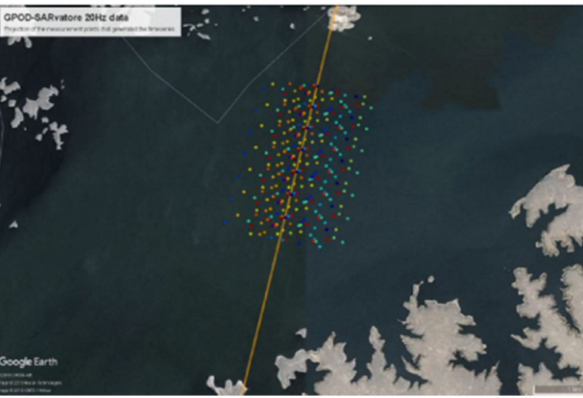
Figure 4. The nominal track of the relative orbit #249 of Sentinel-3A passes through AHDL.